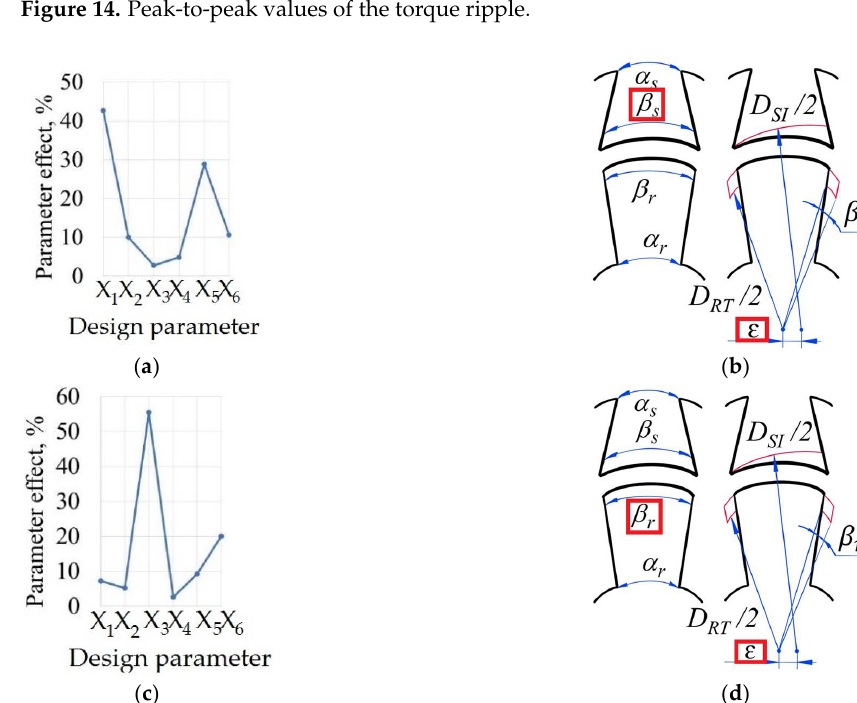
Figure 15. Control factors’ effects on the objectives: ( a ) average torque; ( b ) most influential parameters on average torque; ( c ) torque ripple; ( d ) most influential parameters on torque ripple.